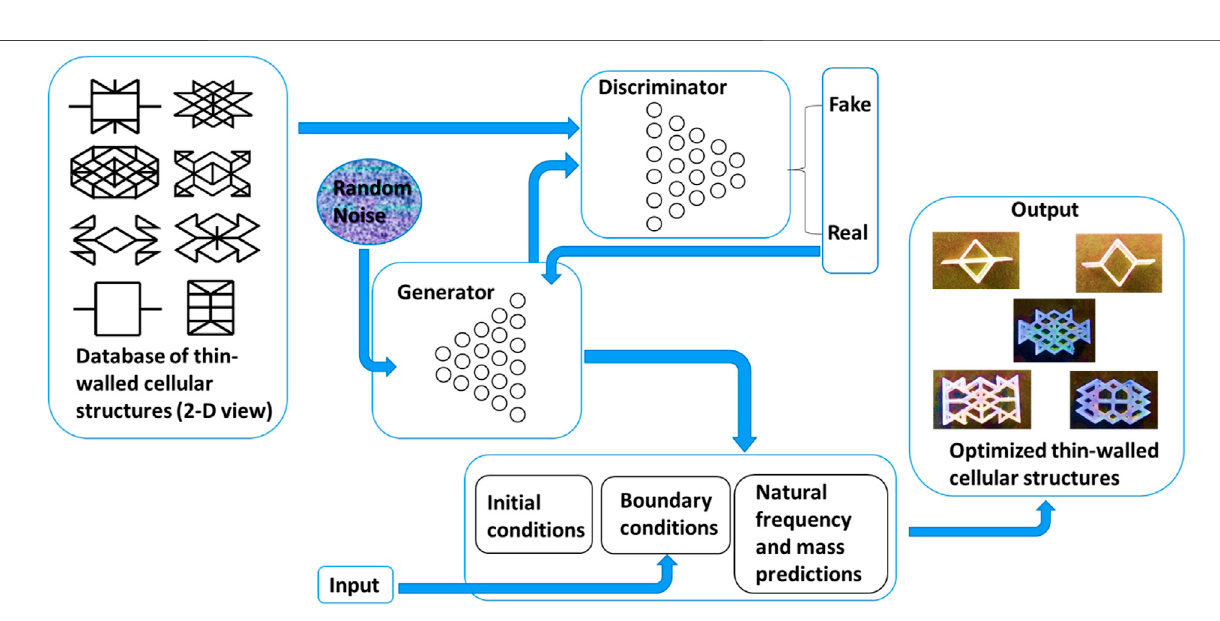
Frontiers in Mechanical Engineering |